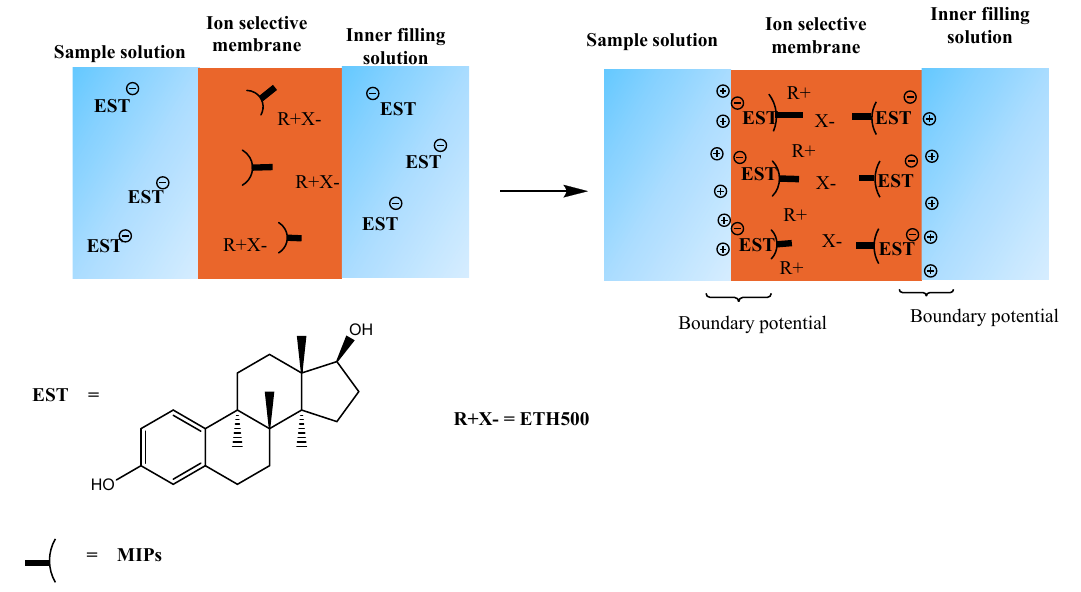
Figure 5. Response mechanism of the proposed 17 β -estradiol sensor.